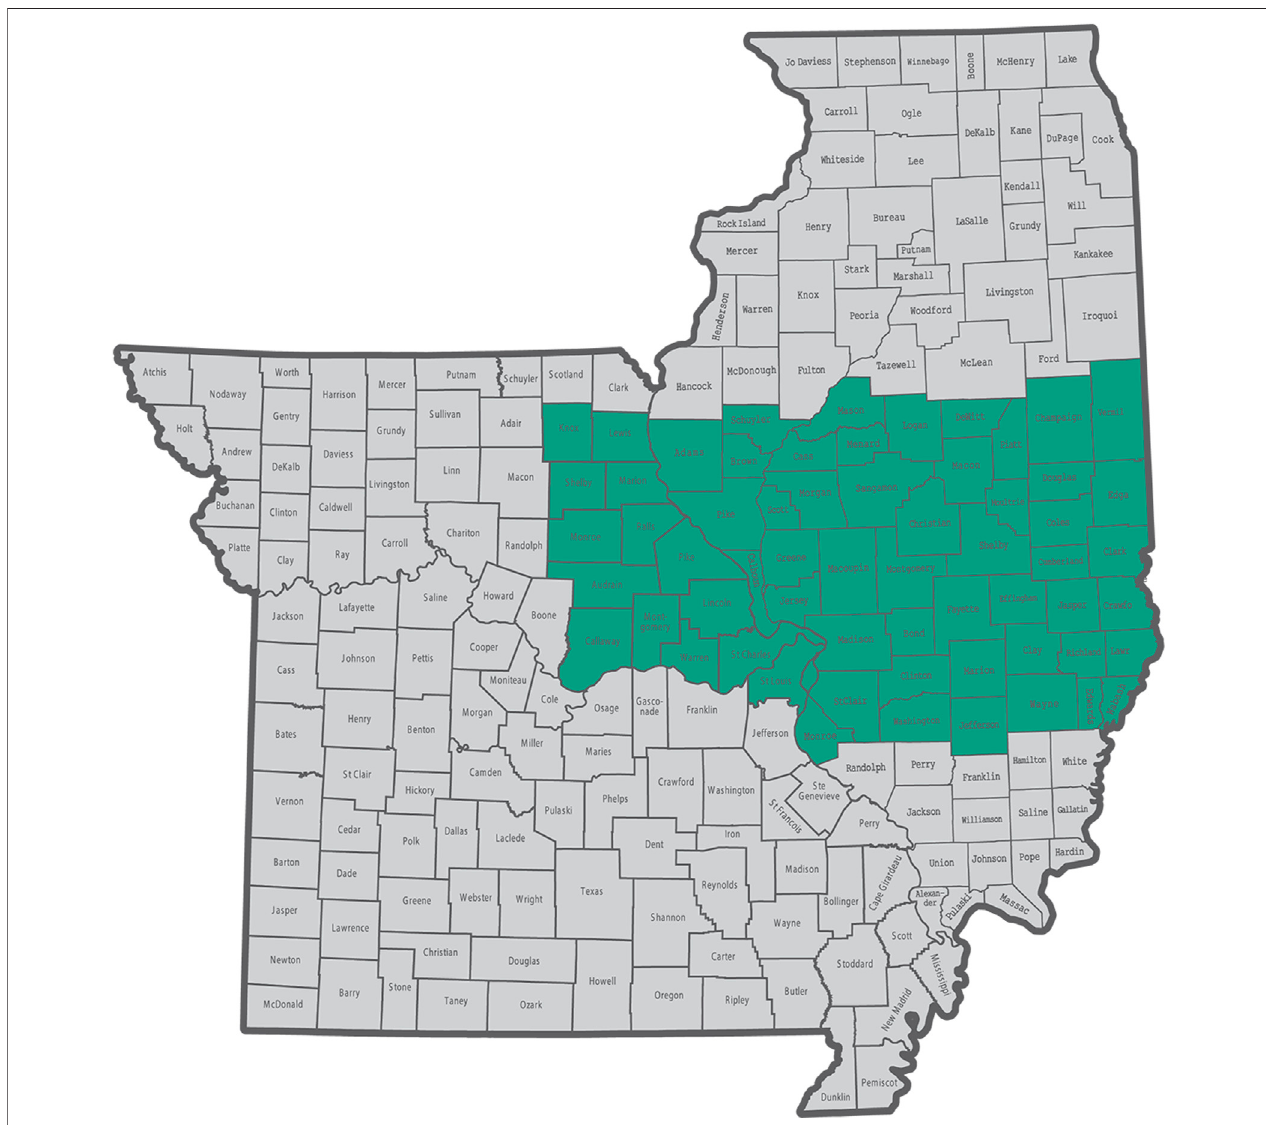
FIGURE 3 | Commercial target launch zone for CoverCress ™ seed in central Illinois and northeast Missouri, USA.